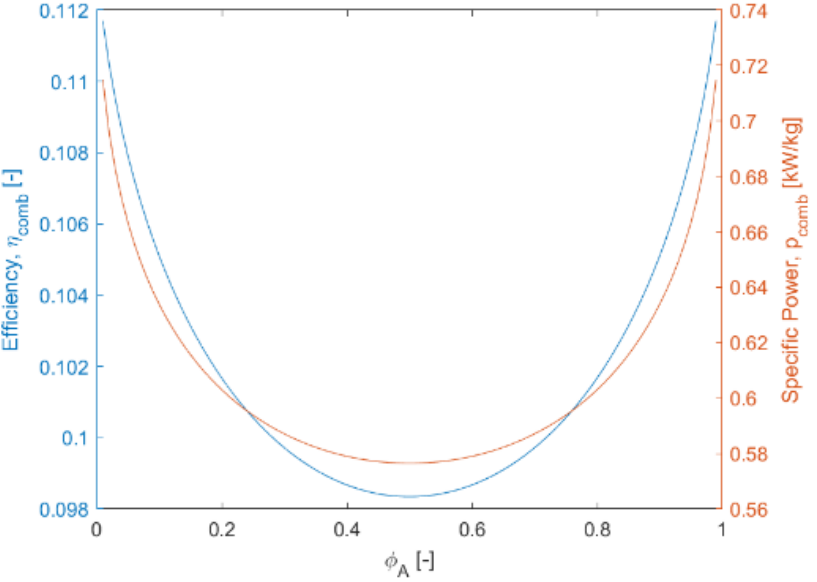
Figure 9. Combined system with non-constant efficiency and power.